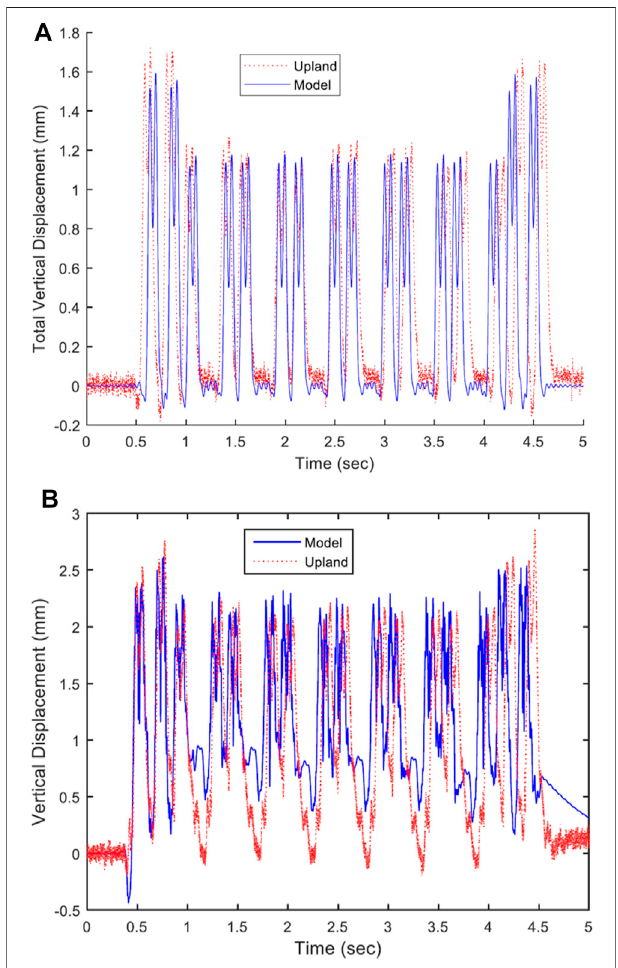
FIGURE 5 | Comparisons between fi eld-measured and model- predicted transient displacements under the passage of an Acela Express passenger train at two different locations: (A) OTL (B) NBL (from Hou et al., 2021).